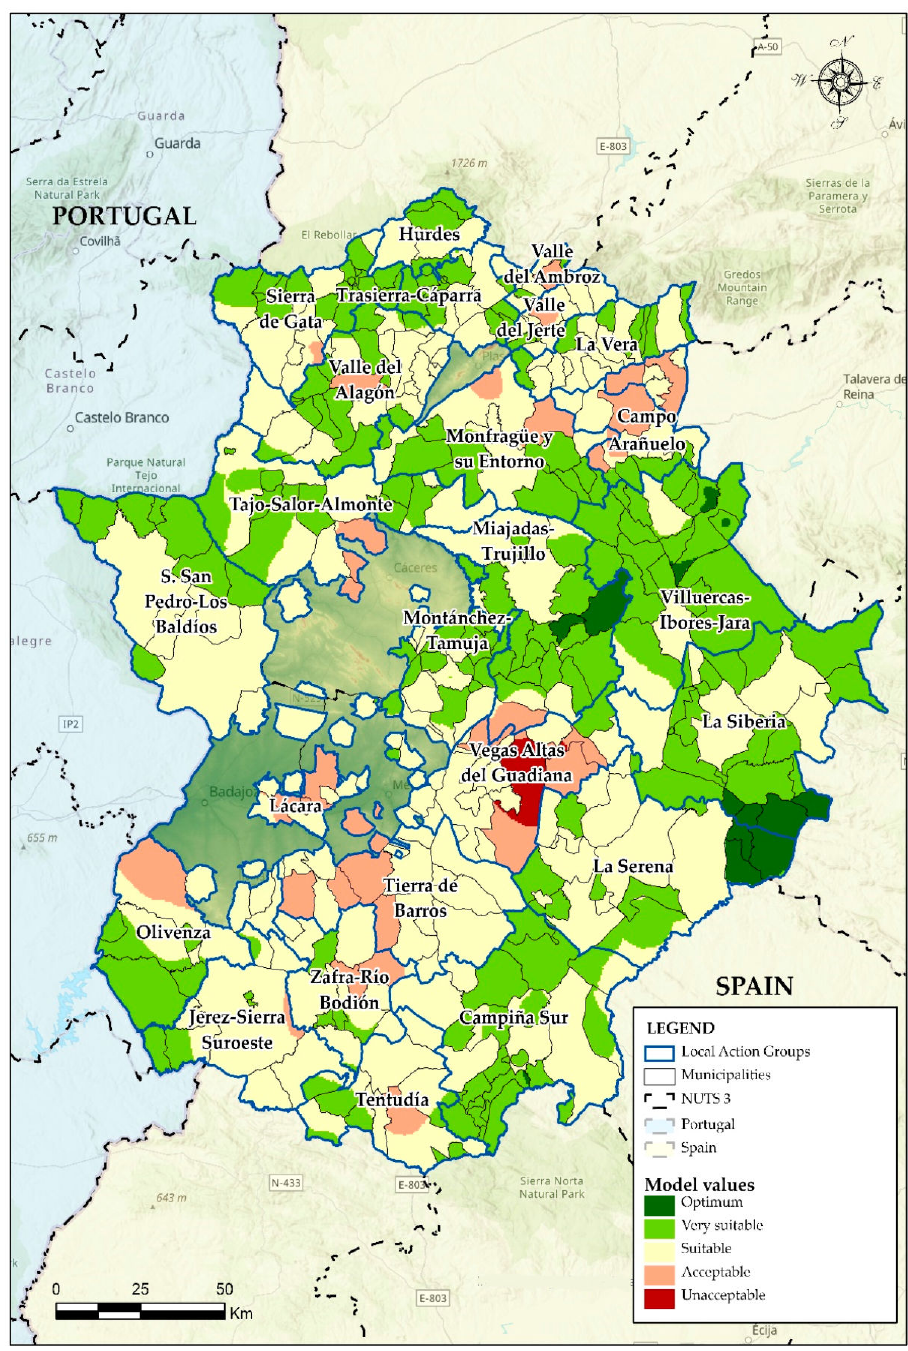
Figure 6. Results of the optimal localization model of LEADER investments in Extremadura. Source: